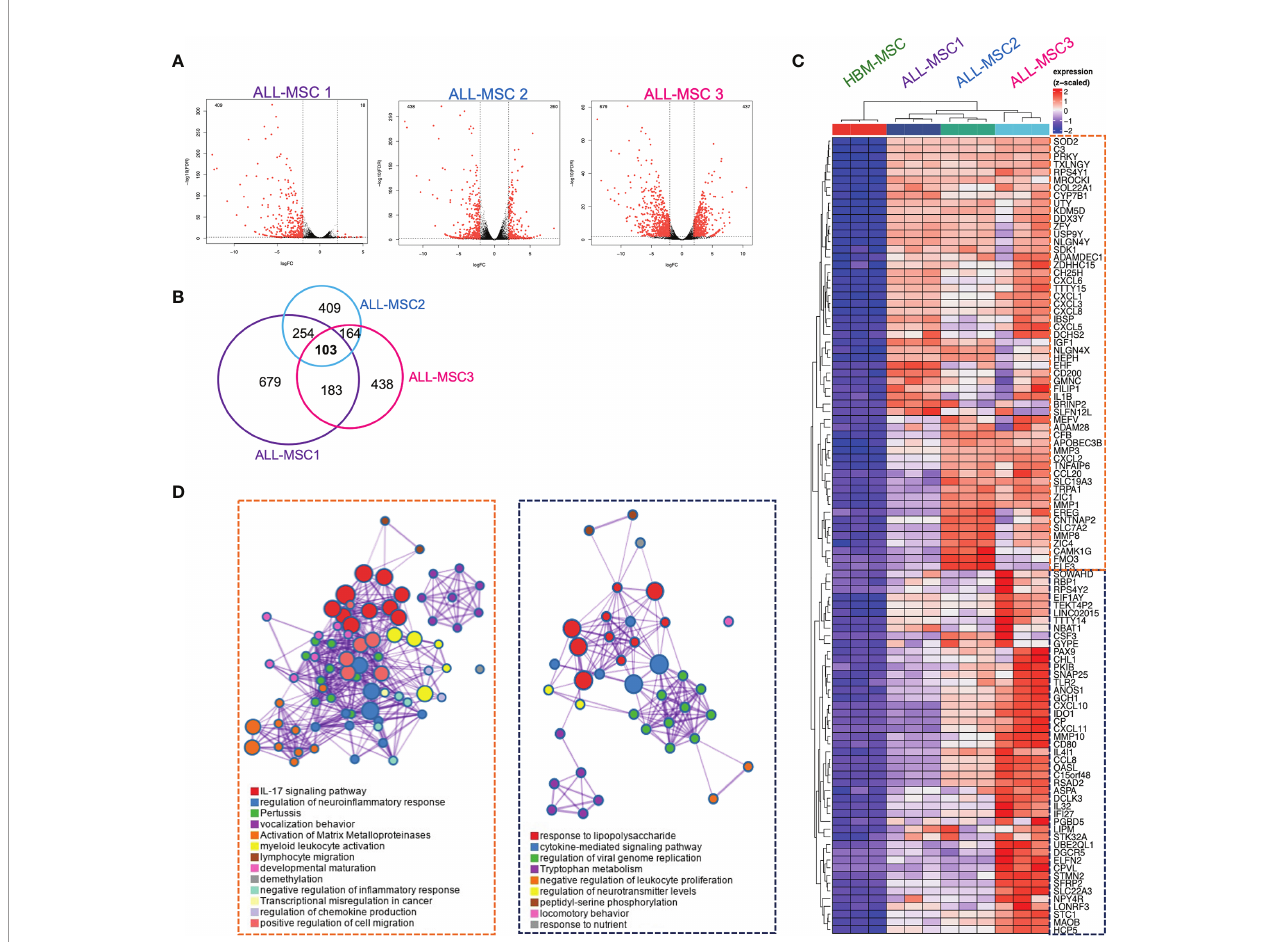
FIGURE 6 | Differentially expressed genes in MSCs derived from B-ALL pediatric patients: RNA-seq approach. (A) Volcano plots of statistically signi fi cant differentially expressed genes from three B-ALL patients compared to normal counterpart from a healthy donor is shown ( n = 3). (B) Venn diagram on intersection analysis of overexpressed genes found in (A) . (C) Heatmap of genes consistently overexpressed after analysis of intersections (fold change > 2 and FDR < 0.05). (D) Gene ontology and functional enrichment analysis is shown for two clusters. Dataset